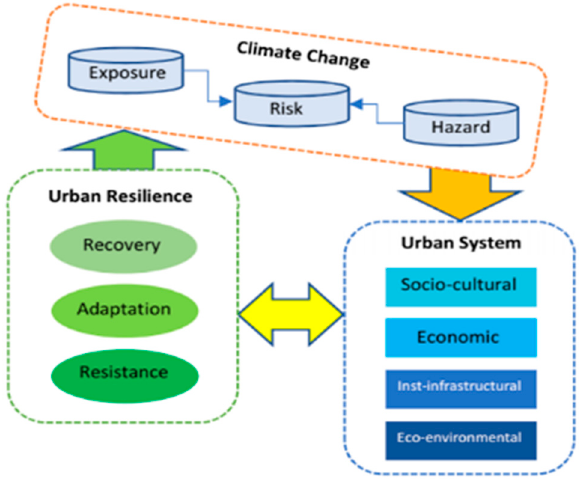
Figure 1. Conceptual framework applied in the study.